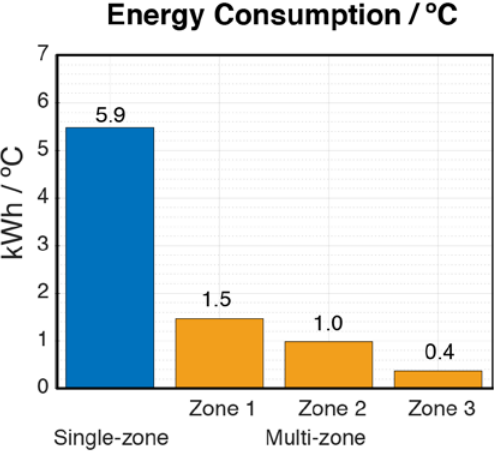
Figure 17. Energy consumption / ◦ C for the whole house (in single-zone mode) and for each of the zones (in multi-zone mode).